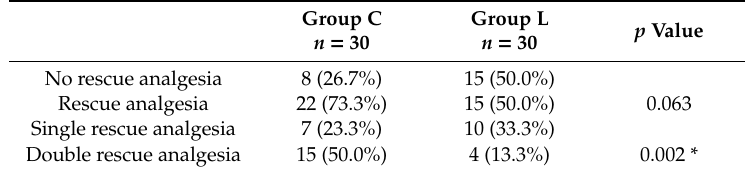
Table 2. The number of patients who received rescue analgesia in the post-anesthesia care unit (PACU).